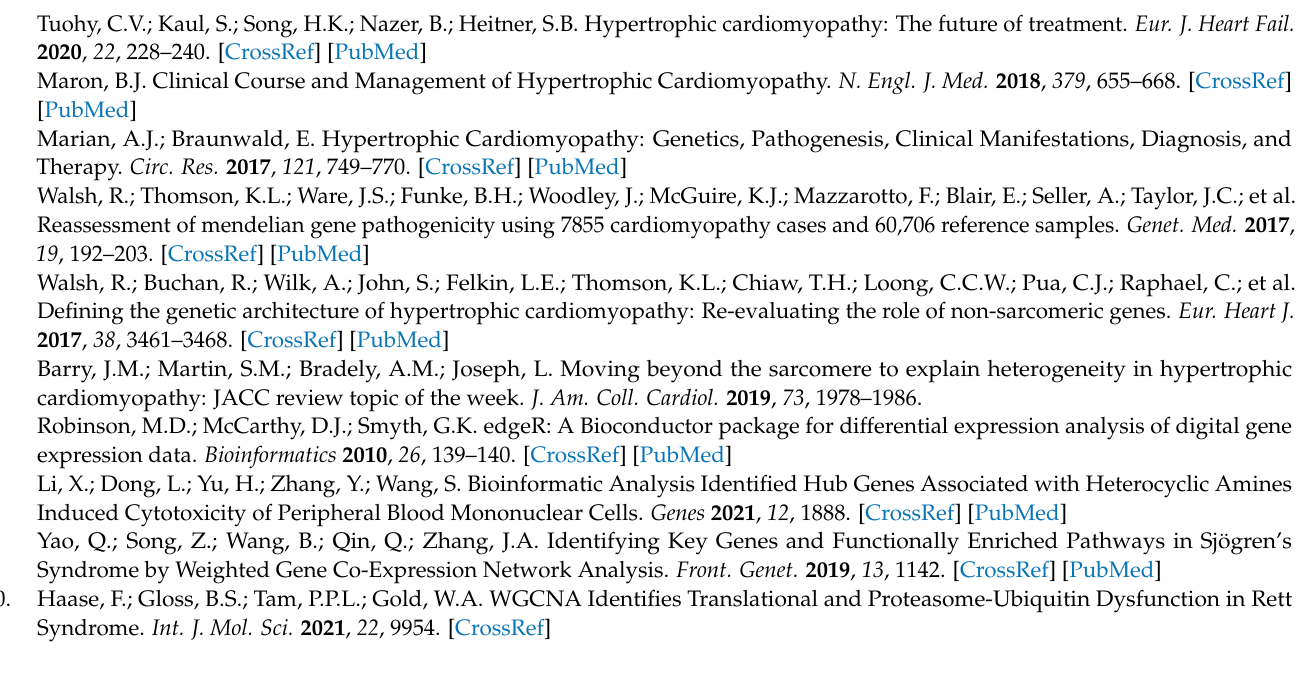
GSEA results of MAFB ; Figure S3: GSEA results of MT1M ; Table S1: Genes correlated with LYVE1 in HCM; Table S2: Genes correlated with MAFB in HCM; Table S3: Genes correlated with MT1M in